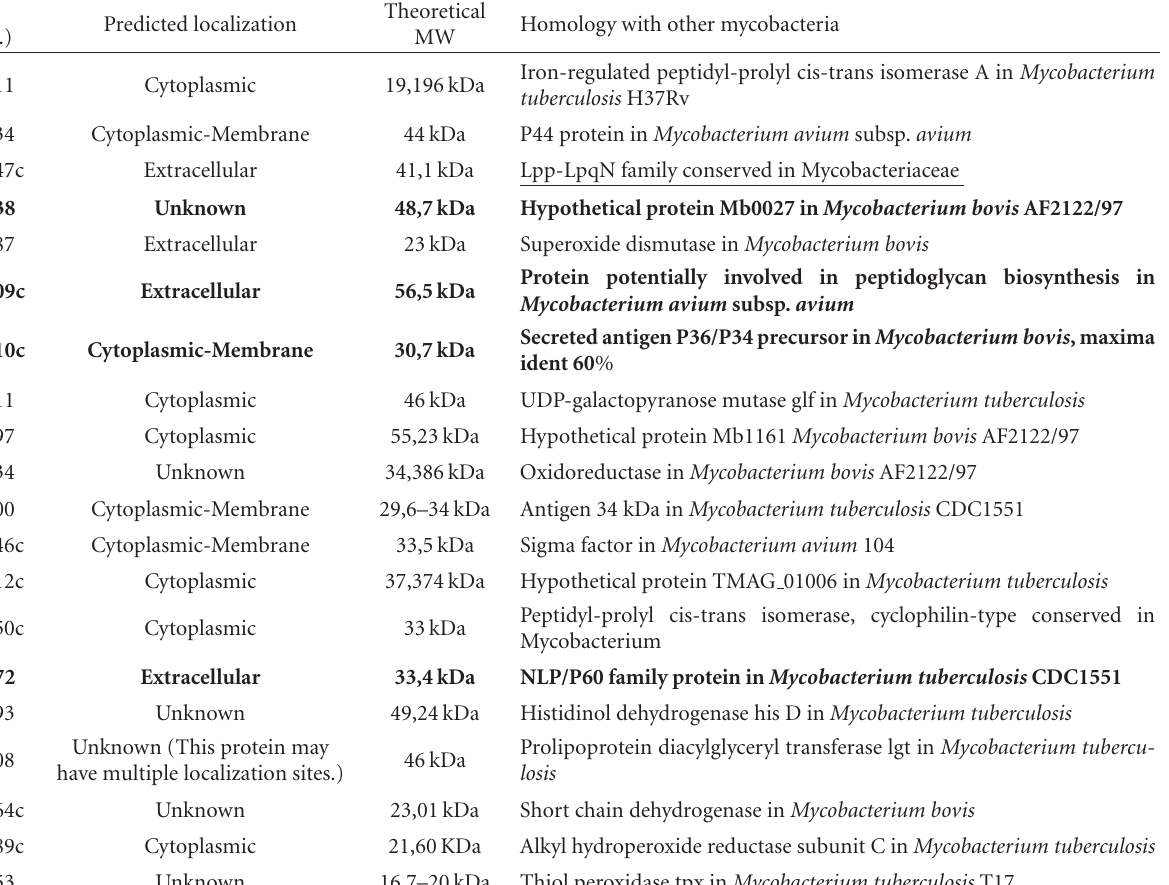
Table 1: Characterization in silico of a panel of 54 recombinant proteins, included in the present study. Antigen (ORF